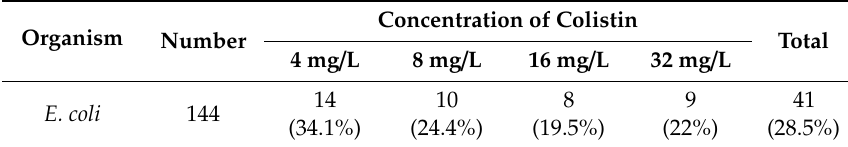
Table 3. Colistin susceptibility pattern of E. coli at di ff erent concentrations.